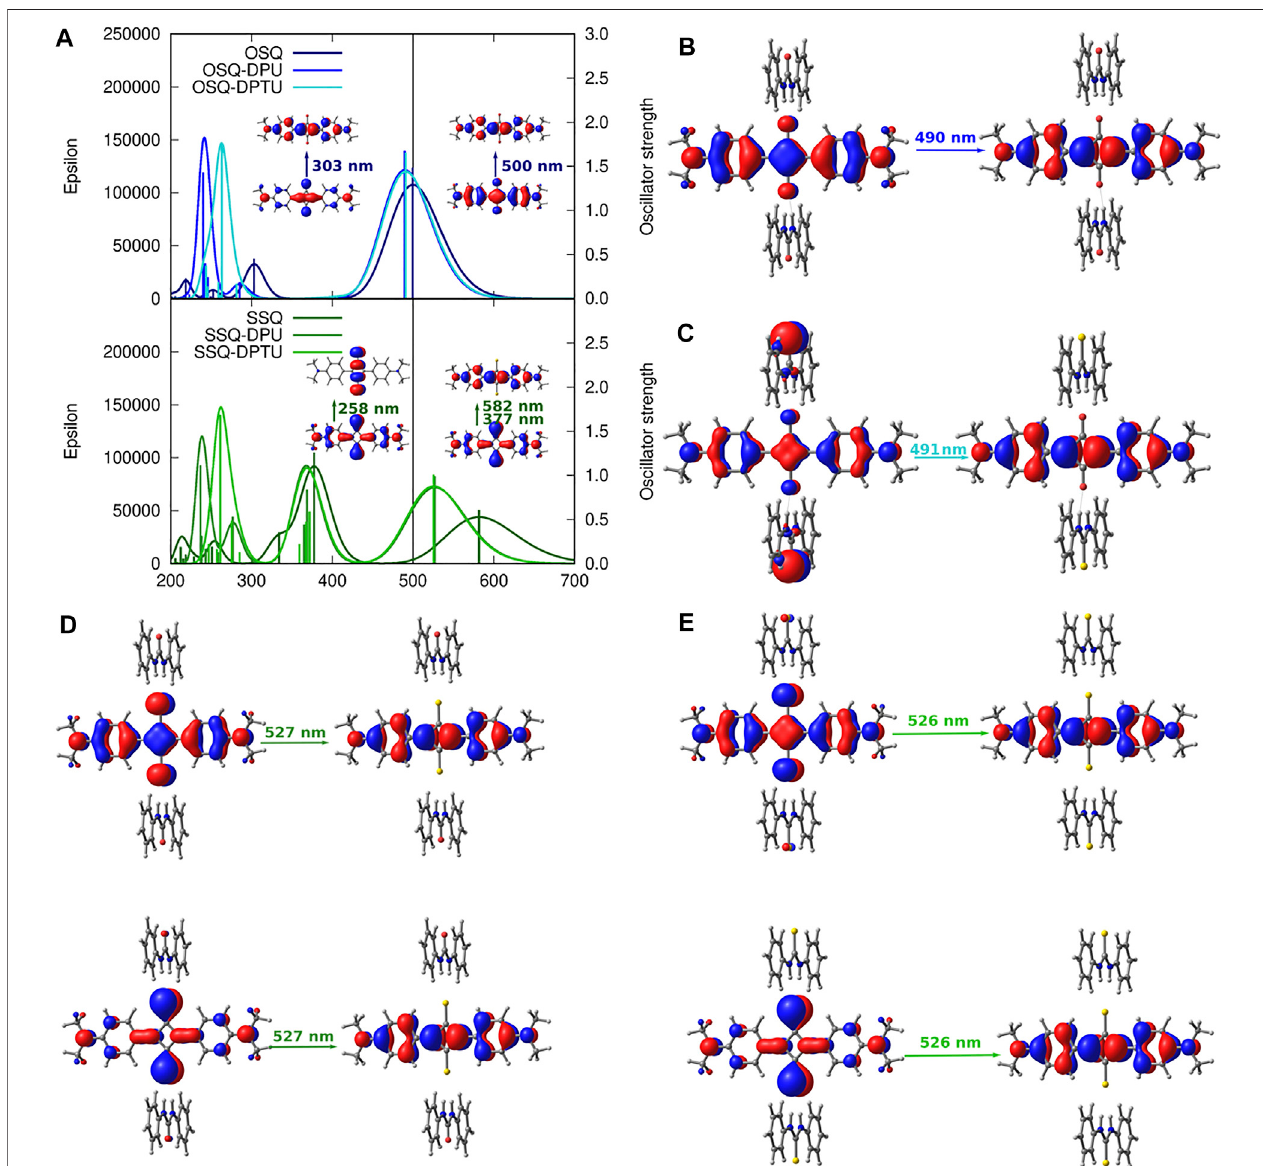
FIGURE12| One-photonabsorption[CAM-B3LYP/6-31+G(d)]togetherwiththecorrespondingorbitalsforinvestigatedsystems: (A) verticalabsorptionspectrum for oxosquaraine and its complexes (upper panel) and thiosqaraine (lower panel) , (B) OSQ-DPU frontier orbitals, (C) OSQ-DPTU frontier orbitals, (D) SSQ-DPU frontier orbitals, and (E) SSQ-DPTU frontier orbitals (convolution of the theoretical oscillator strengths with Gaussian function for full-with half-maximum equal to 3,000 cm − 1 ).